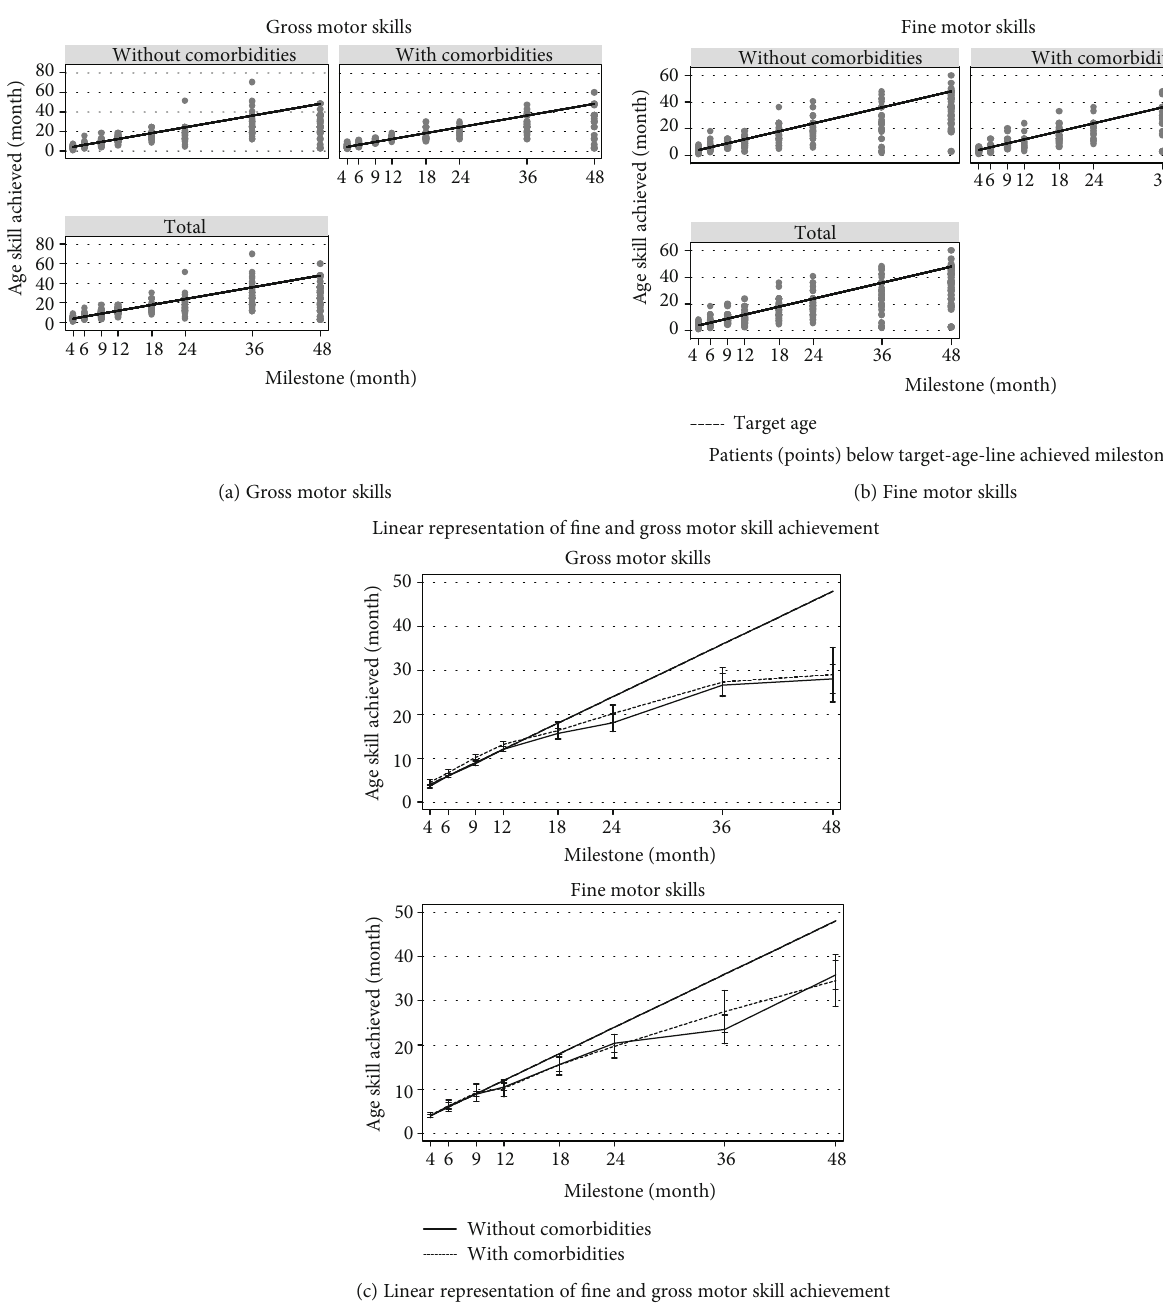
Figure 3: Patients treated with propranolol compared to expected developmental milestone. Each dot represents a patient at a moment in time. Patients below the target line reached the milestone before the target